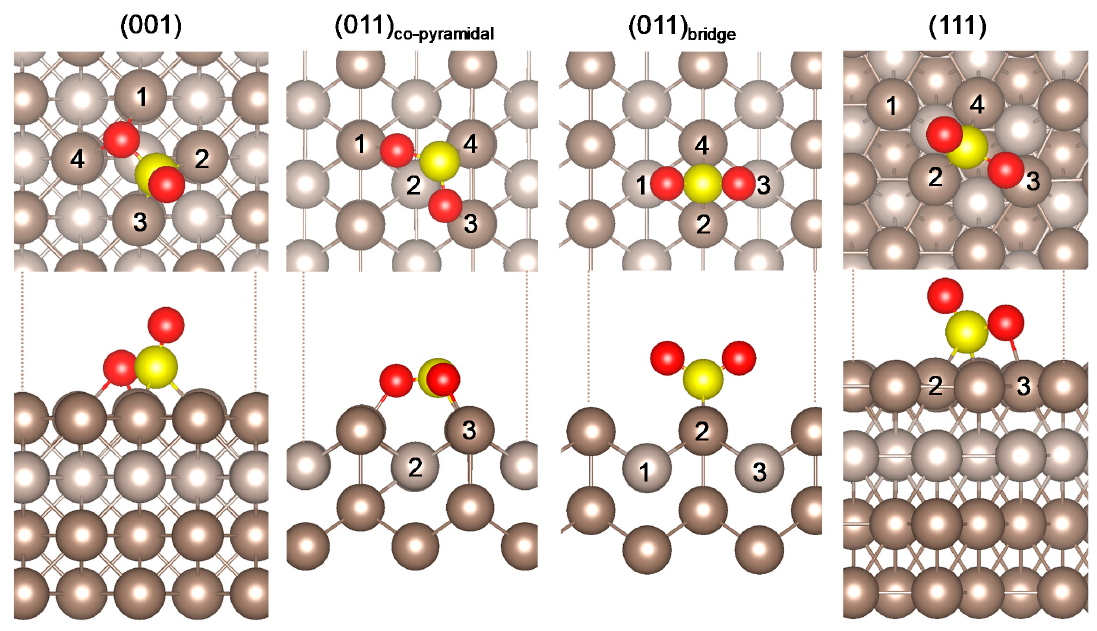
Figure 2. Lowest energy absorption sites of SO 2 on the Pt (001), (011), and (111) surfaces (Pt (011) co − pyramidal and Pt (011) bridge indicate the two adsorption modes of SO 2 on the (011) surface, respectively). The atom colours red and yellow denote oxygen and sulphur atoms, respectively. Table 1. Adsorption energies ( E ads ), bond distances (d), and angles ( ∠ ), as well as the simulated wavenumbers (cm − 1 ) of the fundamental vibration modes of the adsorbed SO 2 on the Pt (001), (011), and (111) surfaces. The presented vibrational modes are the asymmetric stretching ( ν asym ), symmetric stretching ( ν sym ), and bending ( δ ) modes. Charge transfers ( ∆ q ) following SO 2 adsorption on the di ff erent Pt surfaces are also